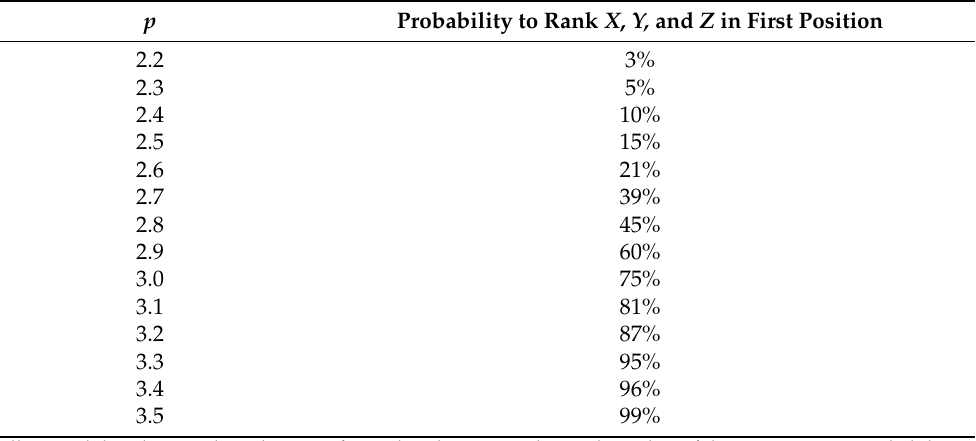
Table 1. Probability to identify properly the X , Y , and Z descriptors from all 24,360 combinations as a function of the p parameter used for cluster